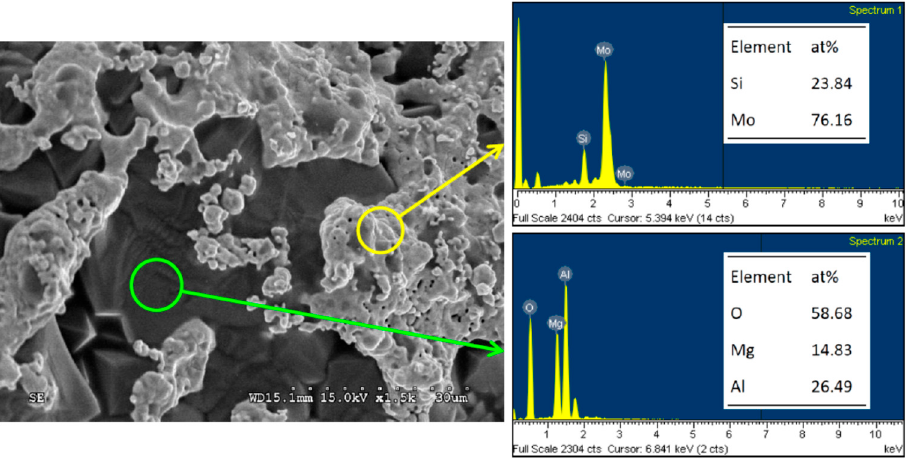
Figure 8. SEM image and EDS element spectra of Mo 3 Si–MgAl 2 O 4 composite synthesized from R(1) with x = 3.